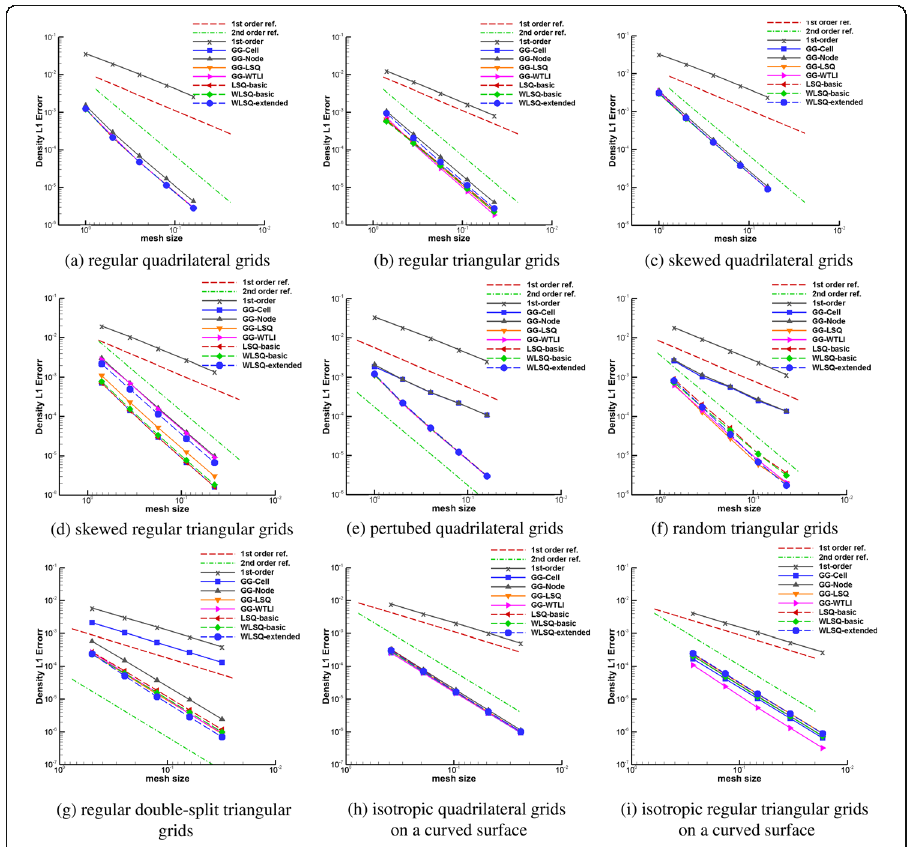
Fig. 13 Convergence of density discretization error on different grids with different reconstruction methods. a Regular quadrilateral grids. b Regular triangular grids. c Skewed quadrilateral grids. d Skewed regular triangular grids. e Perturbed quadrilateral grids. f Random triangular grids. g Regular double-split triangular grids. h Isotropic quadrilateral grids on a curved surface. i Isotropic regular triangular grids on a curved